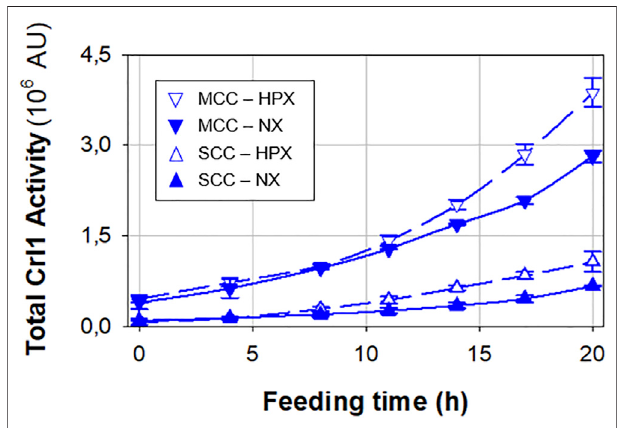
FIGURE 4 | Total Crl1 activity for SCC ( ▲ ) and MCC ( ▼ ) obtained under normoxic ( fi lled symbols) and hypoxic (void symbols) conditions. Error bars represent the SD of biological replicates.